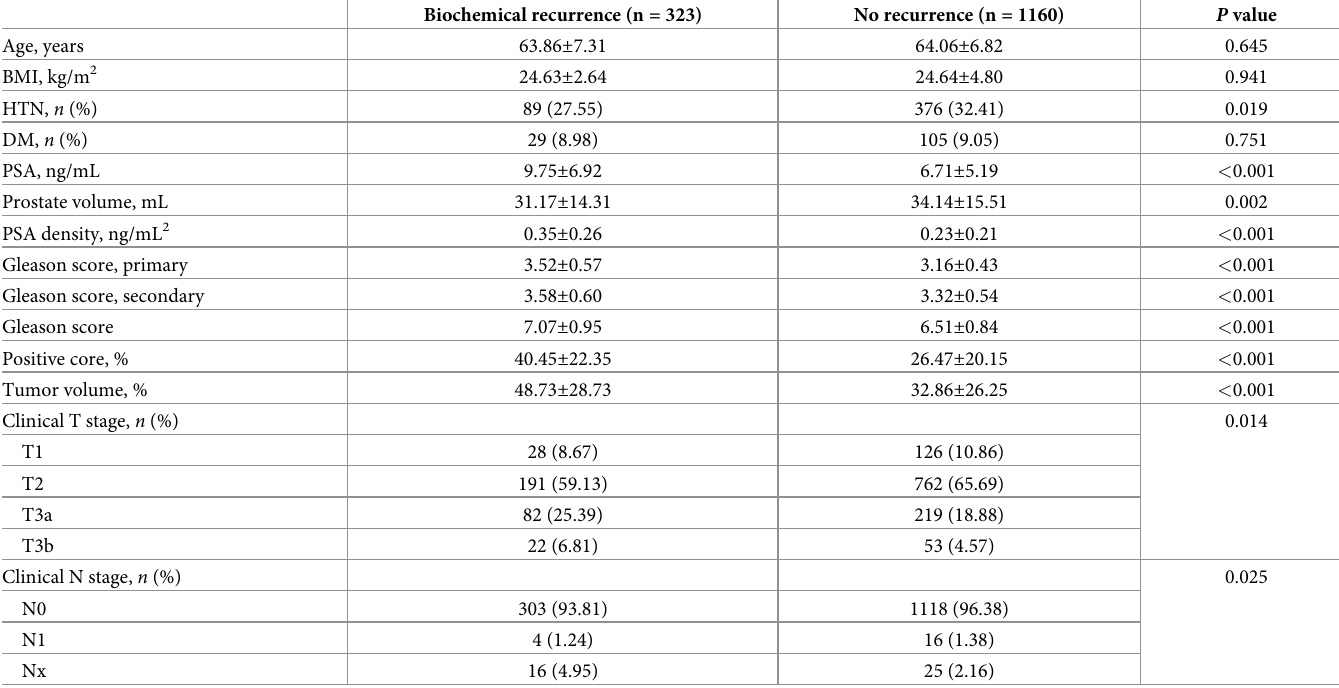
Table 1. Baseline characteristics of patients in the biochemical recurrence versus no-recurrence